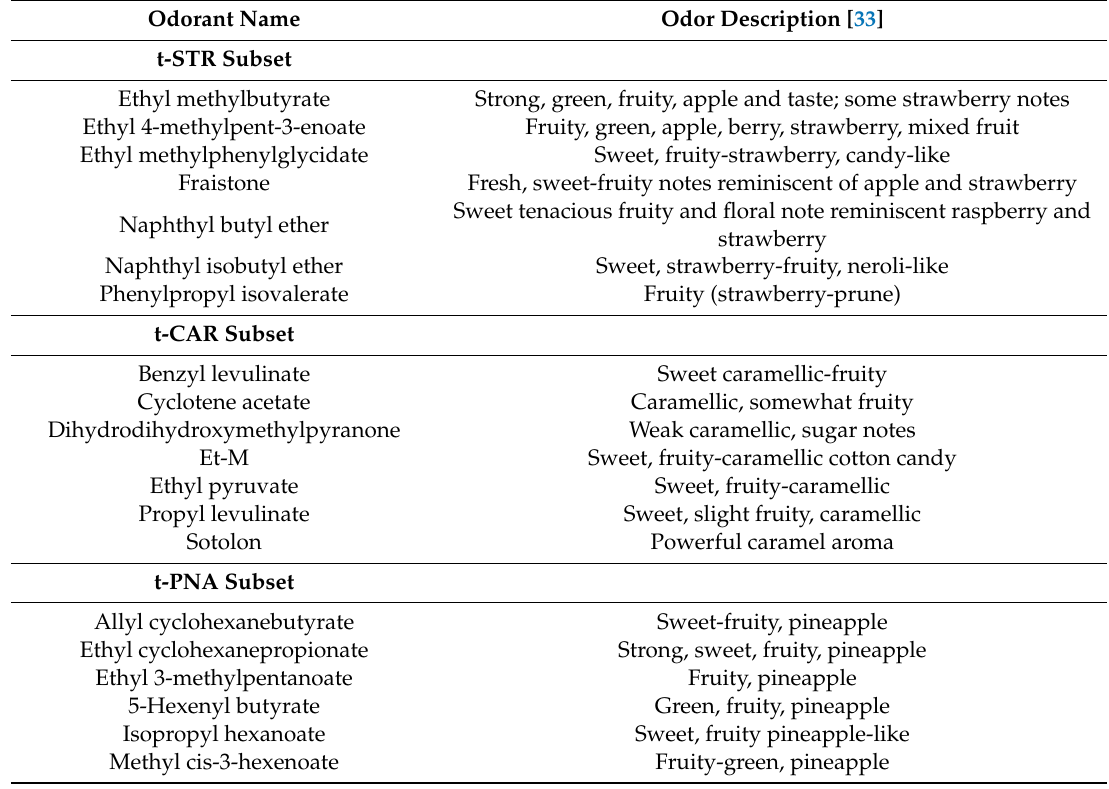
Table 1. Descriptions of odorants in the “true odors”